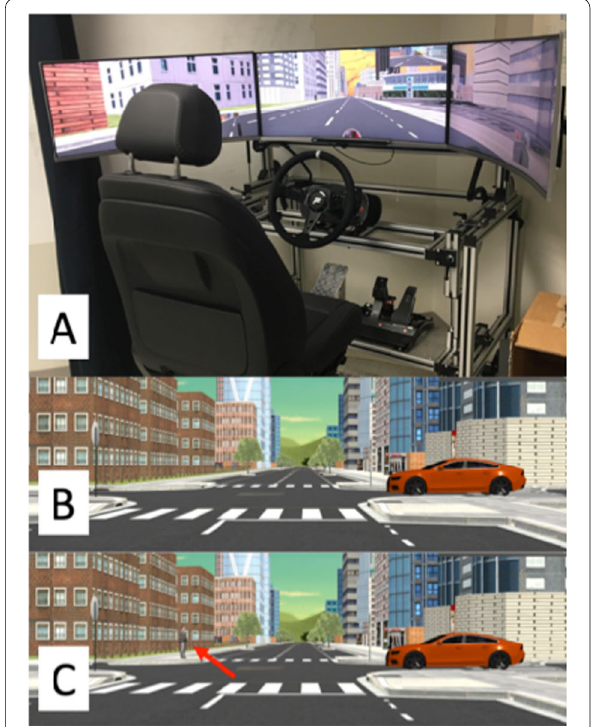
Fig. 1 Images of the driving simulator and virtual world. A The driving simulator. B The center screen showing an intersection without a pedestrian and C The center screen showing a life-size pedestrian (see red arrow) appearing near to the curb as in condition A (see Fig. 2) from a static viewpoint. The car in both ( B ) and ( C ) on the right of the intersection is the cross-traffic on which the participant had to fixate in order to trigger the appearance of the pedestrian (see Fig. 3, bottom panel)